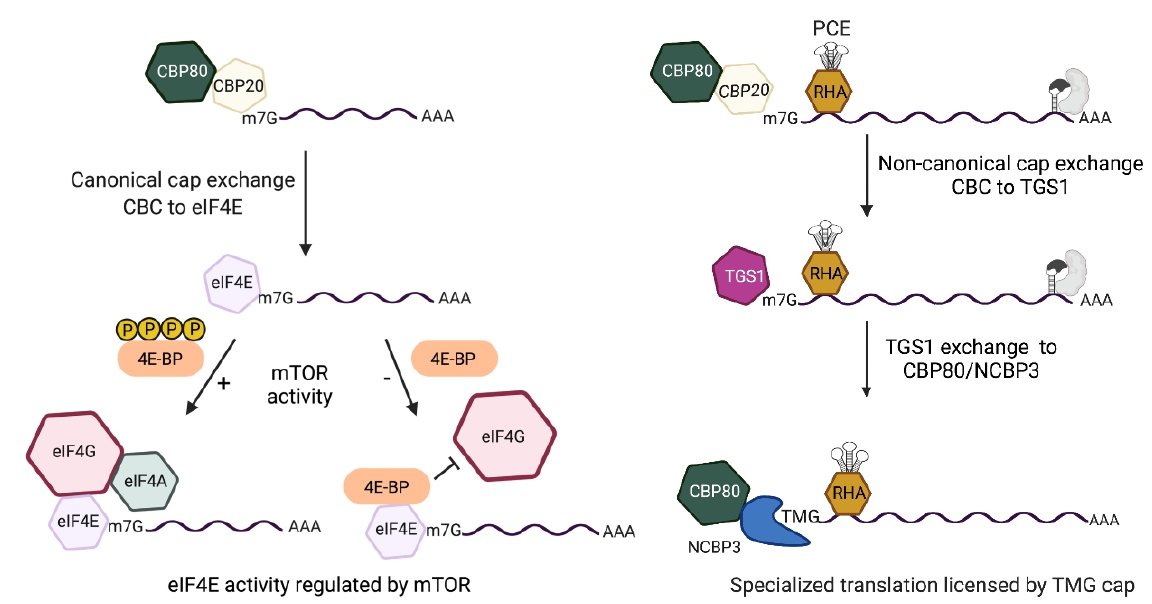
Figure 4. Comparison of the cap-dependent translation pathways of HIV early and late mRNAs that are licensed by m 7 G-cap or m 2,2,7 -trimethylguanosine cap(TMG), respectively. ( Left ) m 7 G-capped early mRNAs assemble nuclear cap-binding complex (CBC) composed of CBP80/CBP20. After nuclear export, CBC exchanges to eIF4E. eIF4E recruits eIF4G/eIF4A for eIF4E-dependent translation initiation that is modulated by mTOR (mechanistic target of rapamycin). Activated mTOR (+) hyper-phosphorylates 4E-binding protein (BP), blocking its interaction with eIF4E. mTOR inhibition ( − ) upregulates hypo-phosphorylated (hypo) 4E-BP for allosteric binding with eIF4E that blocks eIF4G interaction and promptly halts eIF4E-dependent translation. ( Right ) m 7 G-capped late mRNAs contain the Rev-responsive element (RRE) (gray RNA element) and require Rev binding (gray shape). The RRE-dependent mRNAs tether DHX9/RNA helicase A (RHA) through the post-transcriptional control element (PCE) and experience non-canonical CBC exchange to trimethylguanosine synthase 1 (TGS1). TGS1 hypermethylates m 7 G-cap to TMG-cap and exchanges to CBP80-NCBP3 for pecialized translation that is unaffected by mTOR.